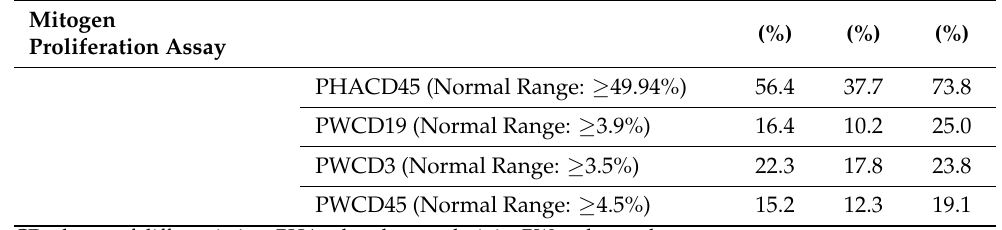
Table 4. Qualitative immune reconstitution of pediatric and adolescent patients following HLA matched-donor HSCT as reported as results following mitogen proliferation